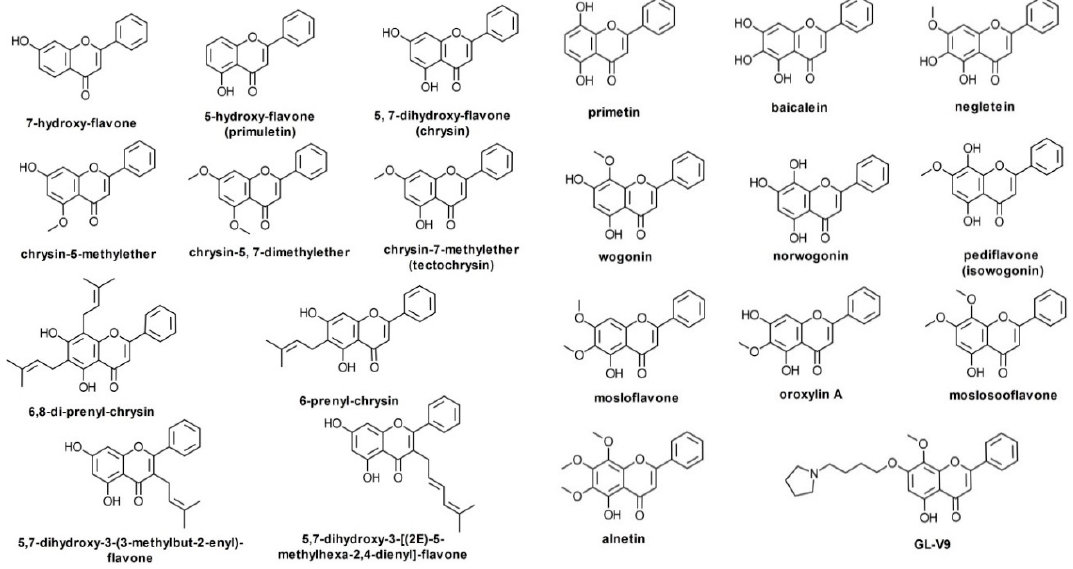
Figure 2. Representative chemical structures of B-ring unsubstituted flavones.